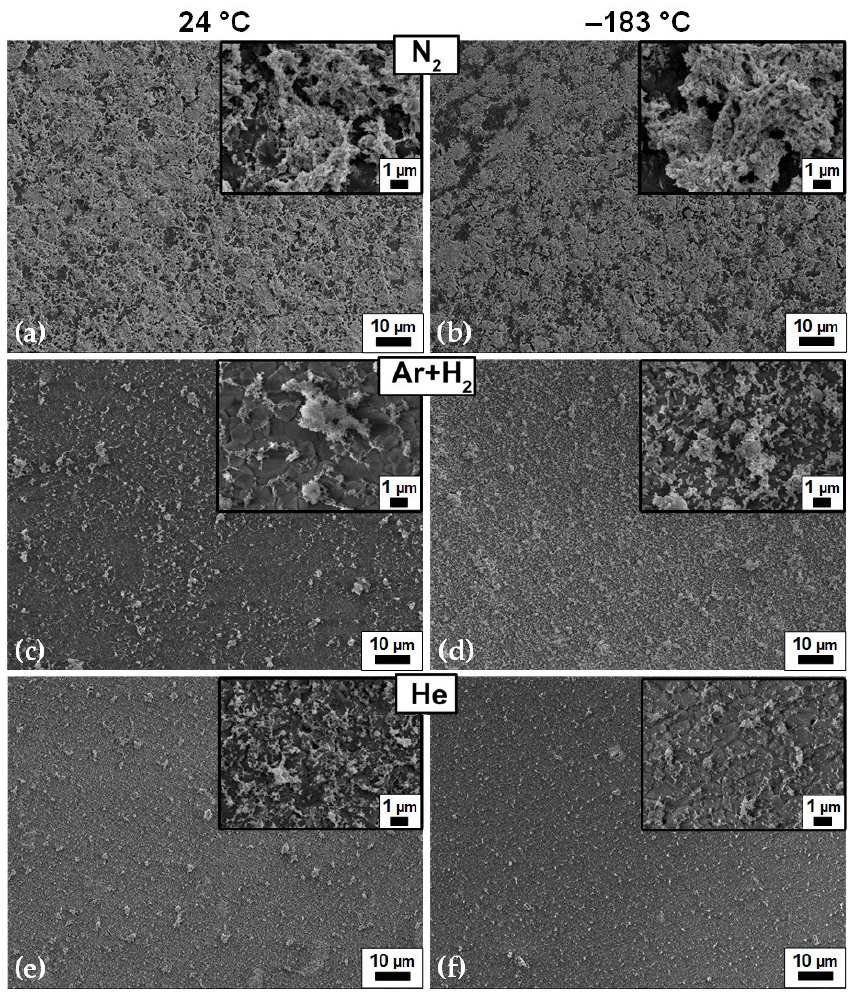
Figure 6. SEM images of SERS structures of Au nanoparticles synthesized in various types of gases (N 2 ( a , b ), Ar + H 2 ( c , d ), and He ( e , f )) at temperatures of 24 °C and −183 °C and deposited on an aluminum oxide (Al 2 O 3 ) substrate. Table 4. Mass production of synthesis and thickness of SERS structures obtained by dry aerosol printing. Synthesis of Au nanoparticles was carried out in nitrogen, argon, and helium at 24 °C and −183 °C, respectively.